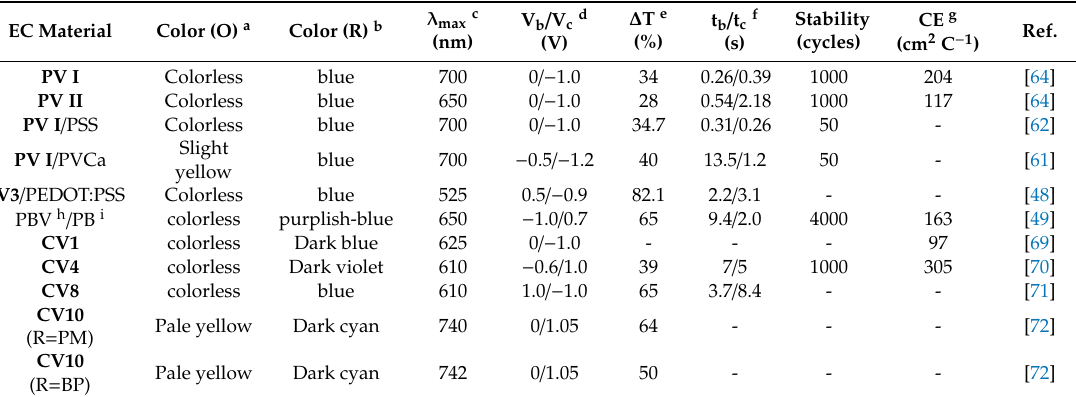
Table 2. ECD performance of selected polyviologens.